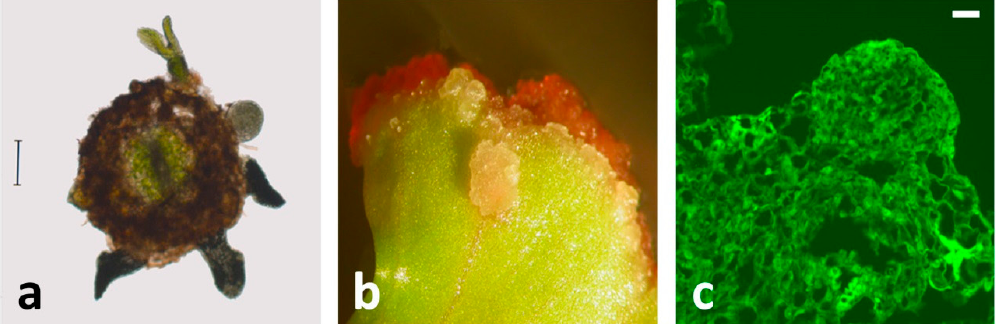
Figure 4. Distribution of AGPs during SE in centaury. ( a ) Cross-section of a root explant with somatic embryos at its surface, stained with β GlcY reagent. Scale bar indicates 80 µm ( b ) Indirect SE on centaury leaf explants grown on 100 µM β GlcY reagent in darkness. Somatic embryos form only on the parts of the explants that are not in direct contact with the medium. ( c )Embryogenic globule developed on leaf explant and labeled with JIM15 antibody. Scale bar indicates 10 µm.